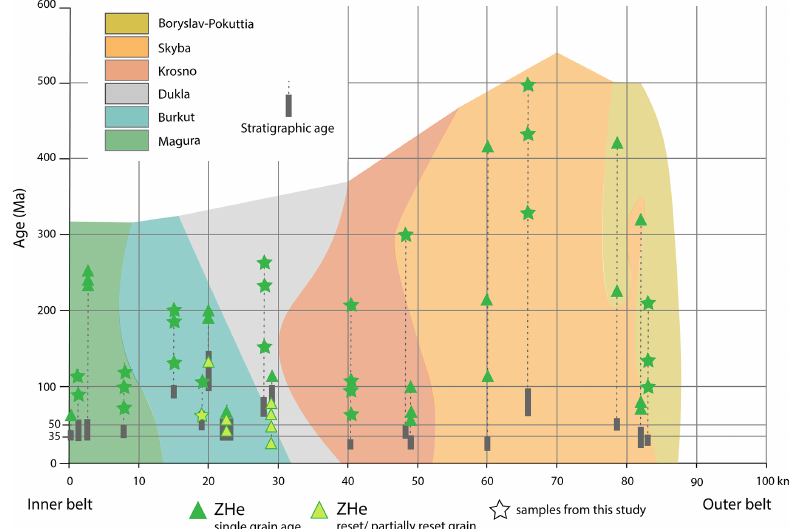
Figure 12. Distribution of ZHe ages across the Ukrainian Carpathians as a function of distance from the inner to the outer belt. Stars represent data from this study; triangles are previously published data. Grey boxes indicate the stratigraphic age of the sample, and dashed lines mark the corresponding thermochronological ages. Colored areas represent the different